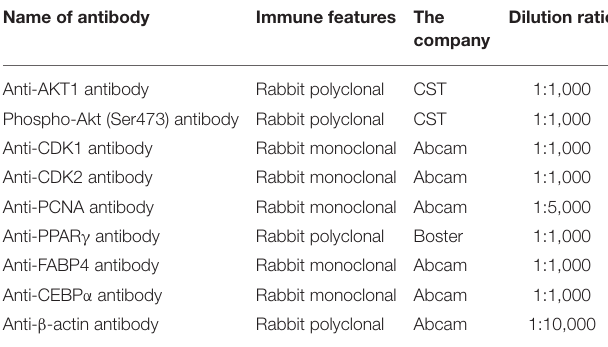
TABLE 3 | Antibody